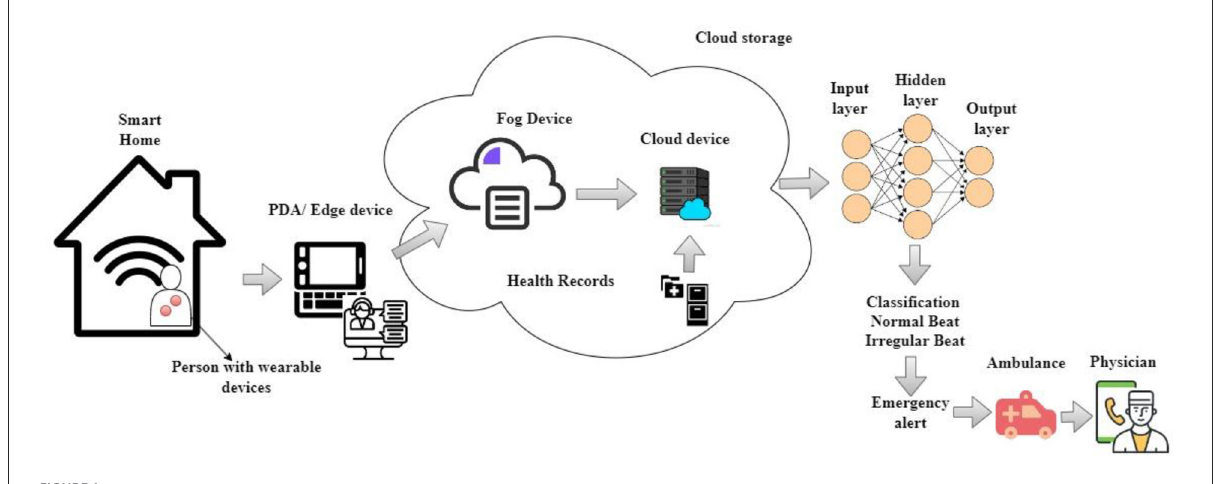
FIGURE1 Architecture of NC-RNN in a smart city